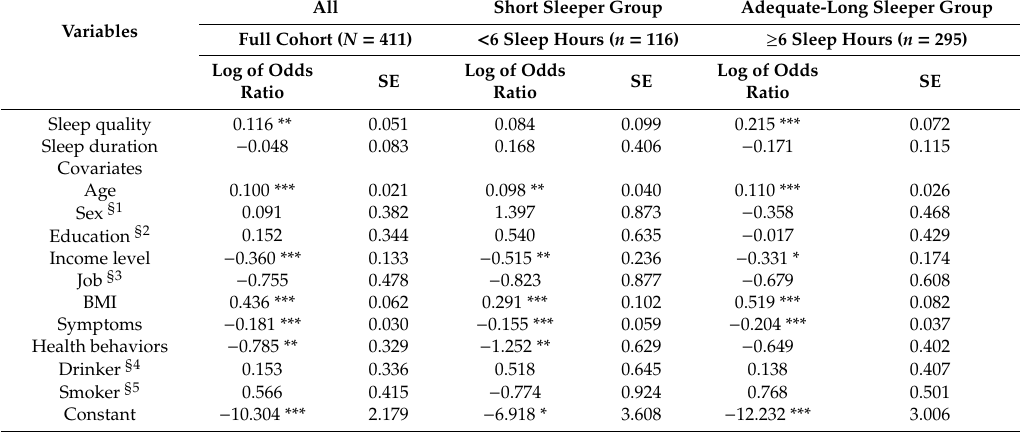
Table 2. Logistic regression analysis for interactive e ff ects of sleep quality and sleep duration on the risk of